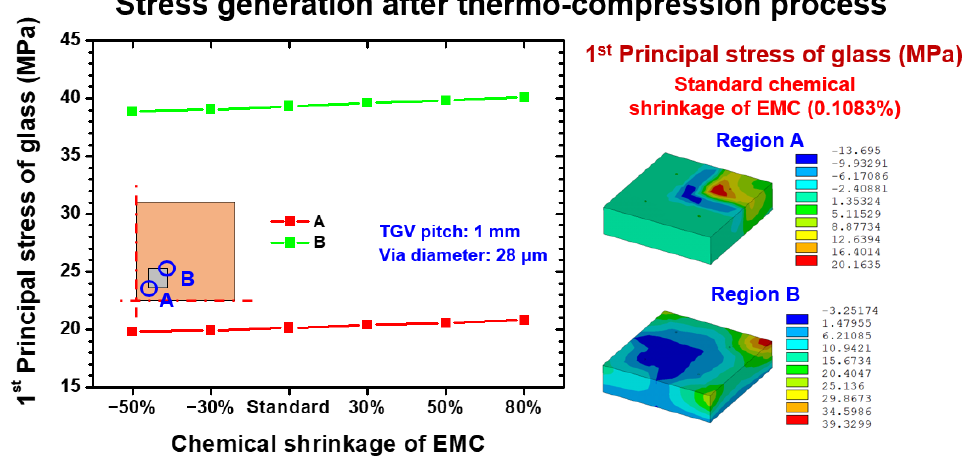
Figure 7. EMC shrinkage dependence first principal stress on the relevant location of the glass interposer after the thermocompression process.